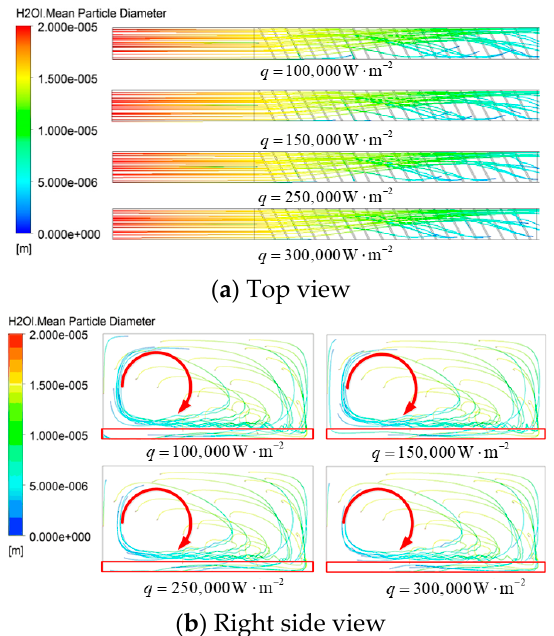
Figure 16. Variation in the droplet motion trajectory of the mist/steam cooling channel with the wall heat flux density.